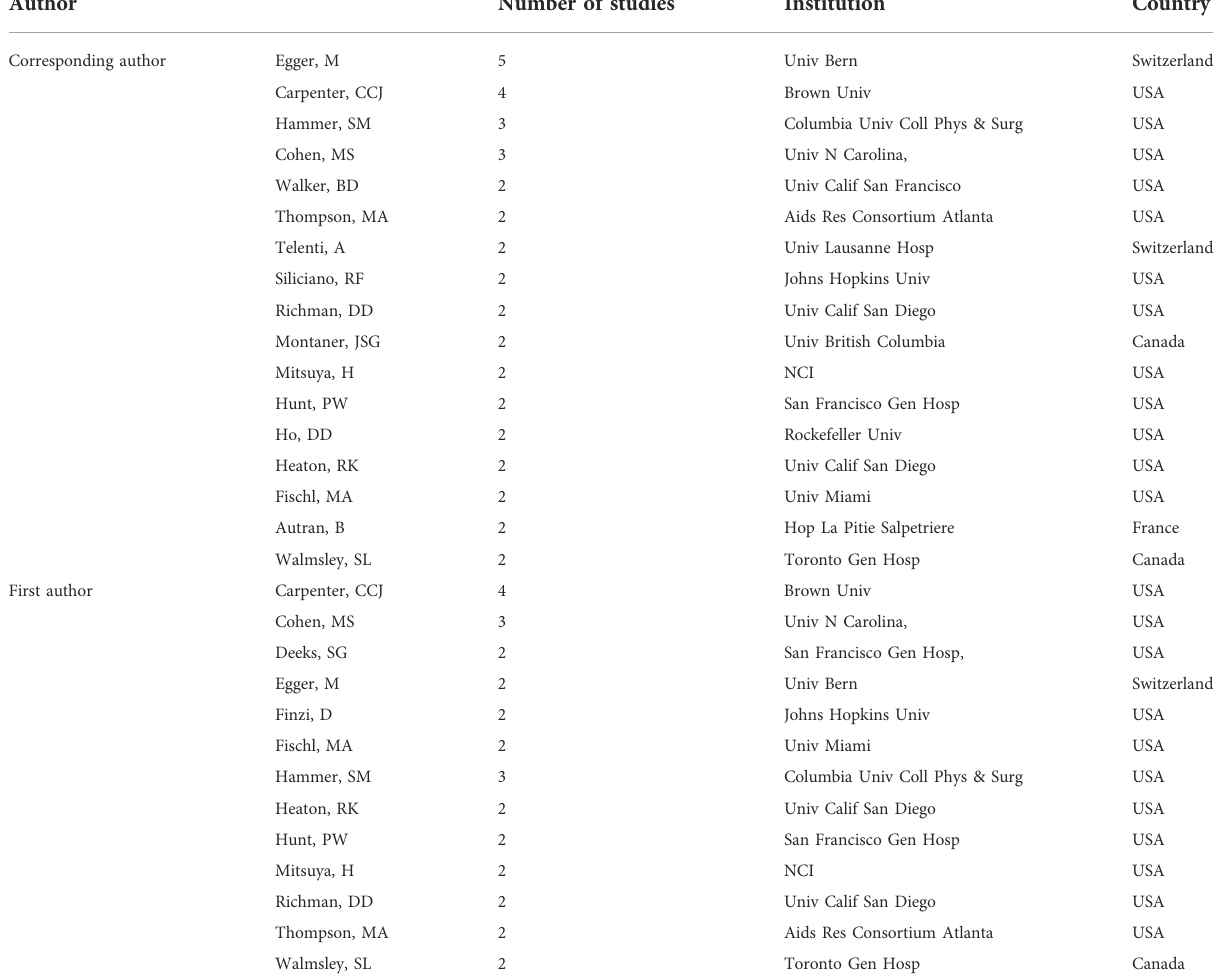
TABLE 4 Authors with more than 1 paper as fi rst author or corresponding author included in the top-100